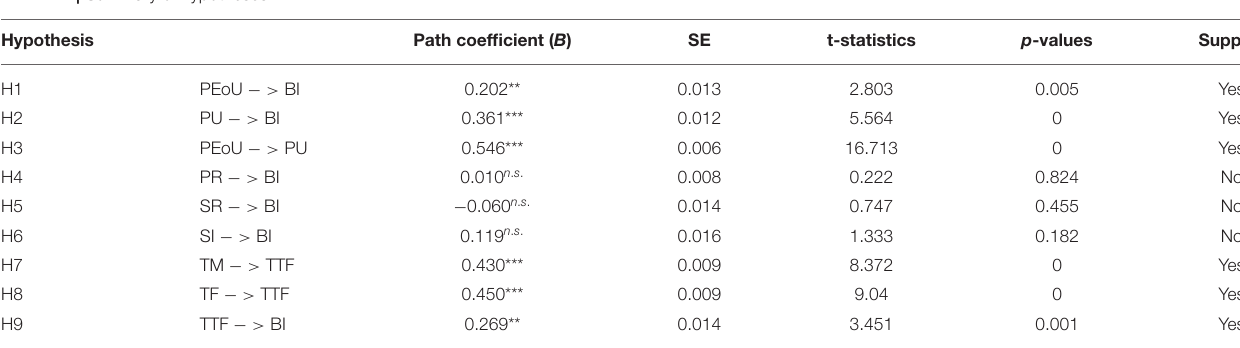
TABLE 7 | Summary of